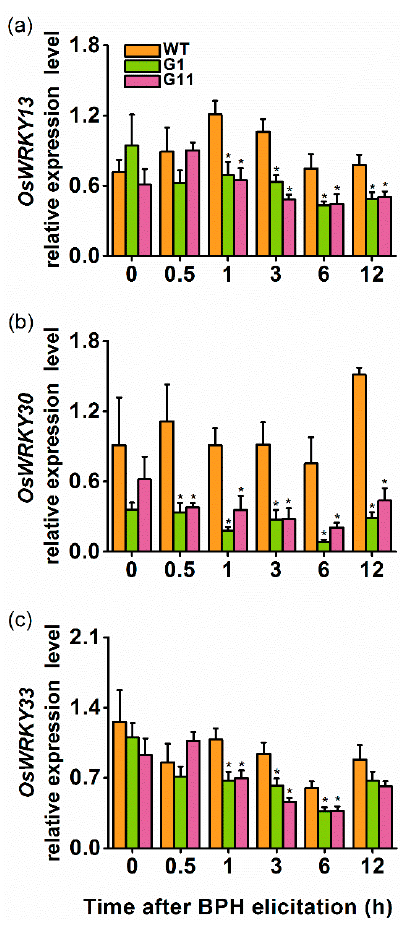
Figure 4. Overexpression of OsGID1 decreases transcript levels of three WRKY TF genes. Relative levels (means + SE, n = 4–5) of OsWRKY13 ( a ), OsWRKY30 ( b ), and OsWRKY33 ( c ) transcripts in oe-GID1 and WT plants after infestation by gravid BPH females. Asterisks indicate significant differences in oe-GID1 plants, compared with WT plants (Duncan’s multiple range test; * p < 0.05).